Question: Which visualization type does this figure use?
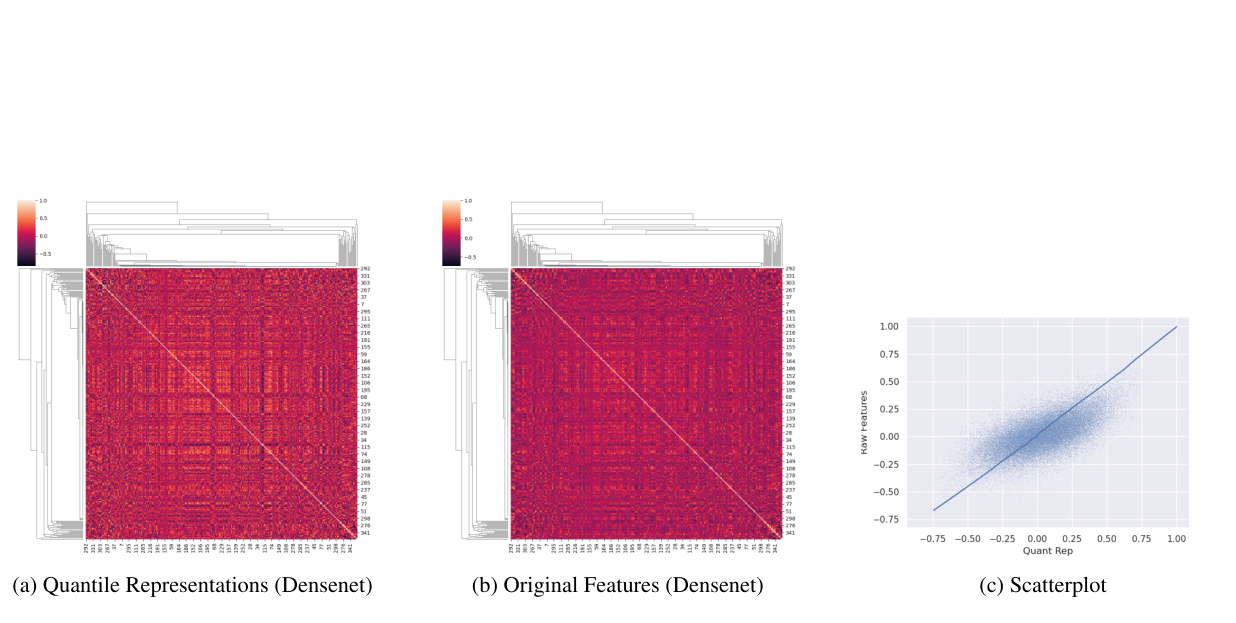
Answer: scatter